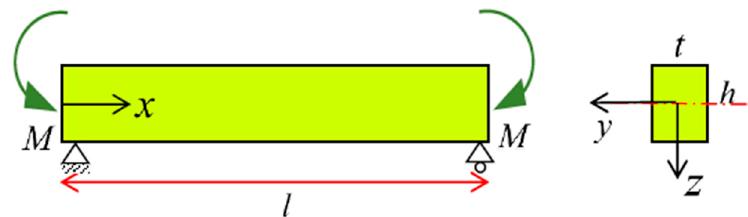
Figure 10. Rectangular beam subjected to the pure bending. Table 3. General moment and force equations for the rectangular beam subjected to the pure bending problem. Parameters Values